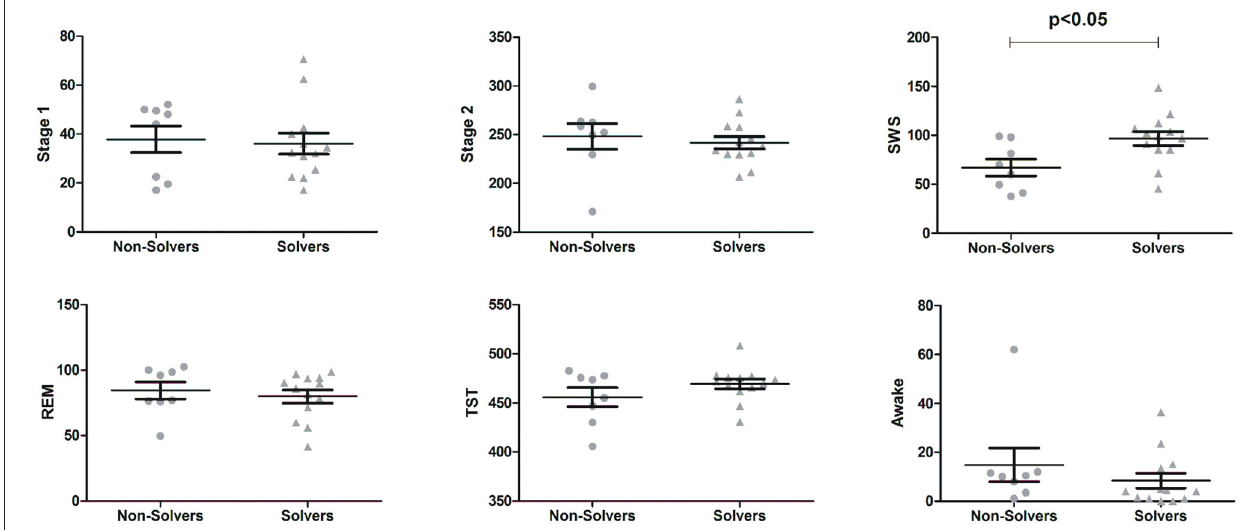
FIGURE 3 | Sleep duration in different sleep stages for subjects from the Sleep group separated by those who solved the problem (Solvers, n = 13) and those who did not solve the problem (Non-Solvers, n = 8). Means ± Standard Errors of the Means are presented for Stage 1 sleep, Stage 2 sleep, slow wave sleep (SWS), rapid-eye movement (REM) sleep, Total Sleep Time (TST), and time awake after sleep